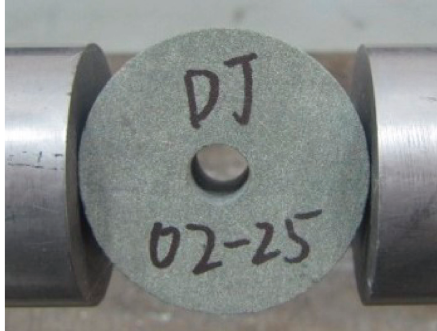
Figure 1: The clamping state of